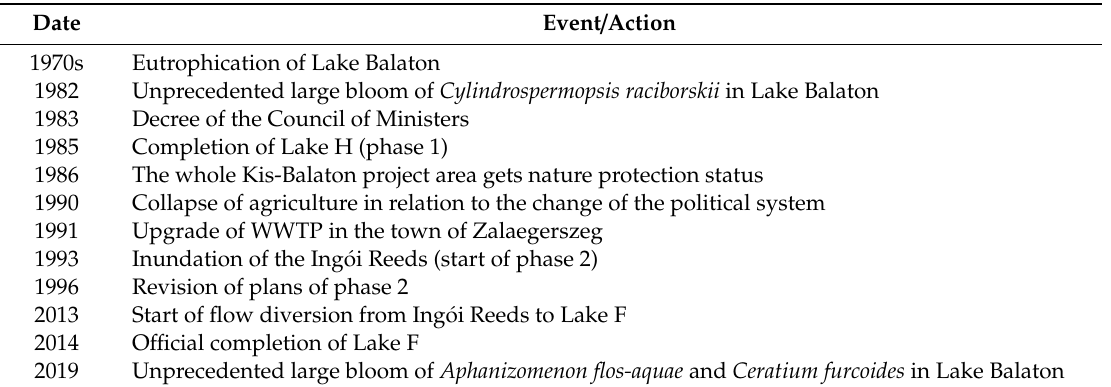
Table 1. Timeline of